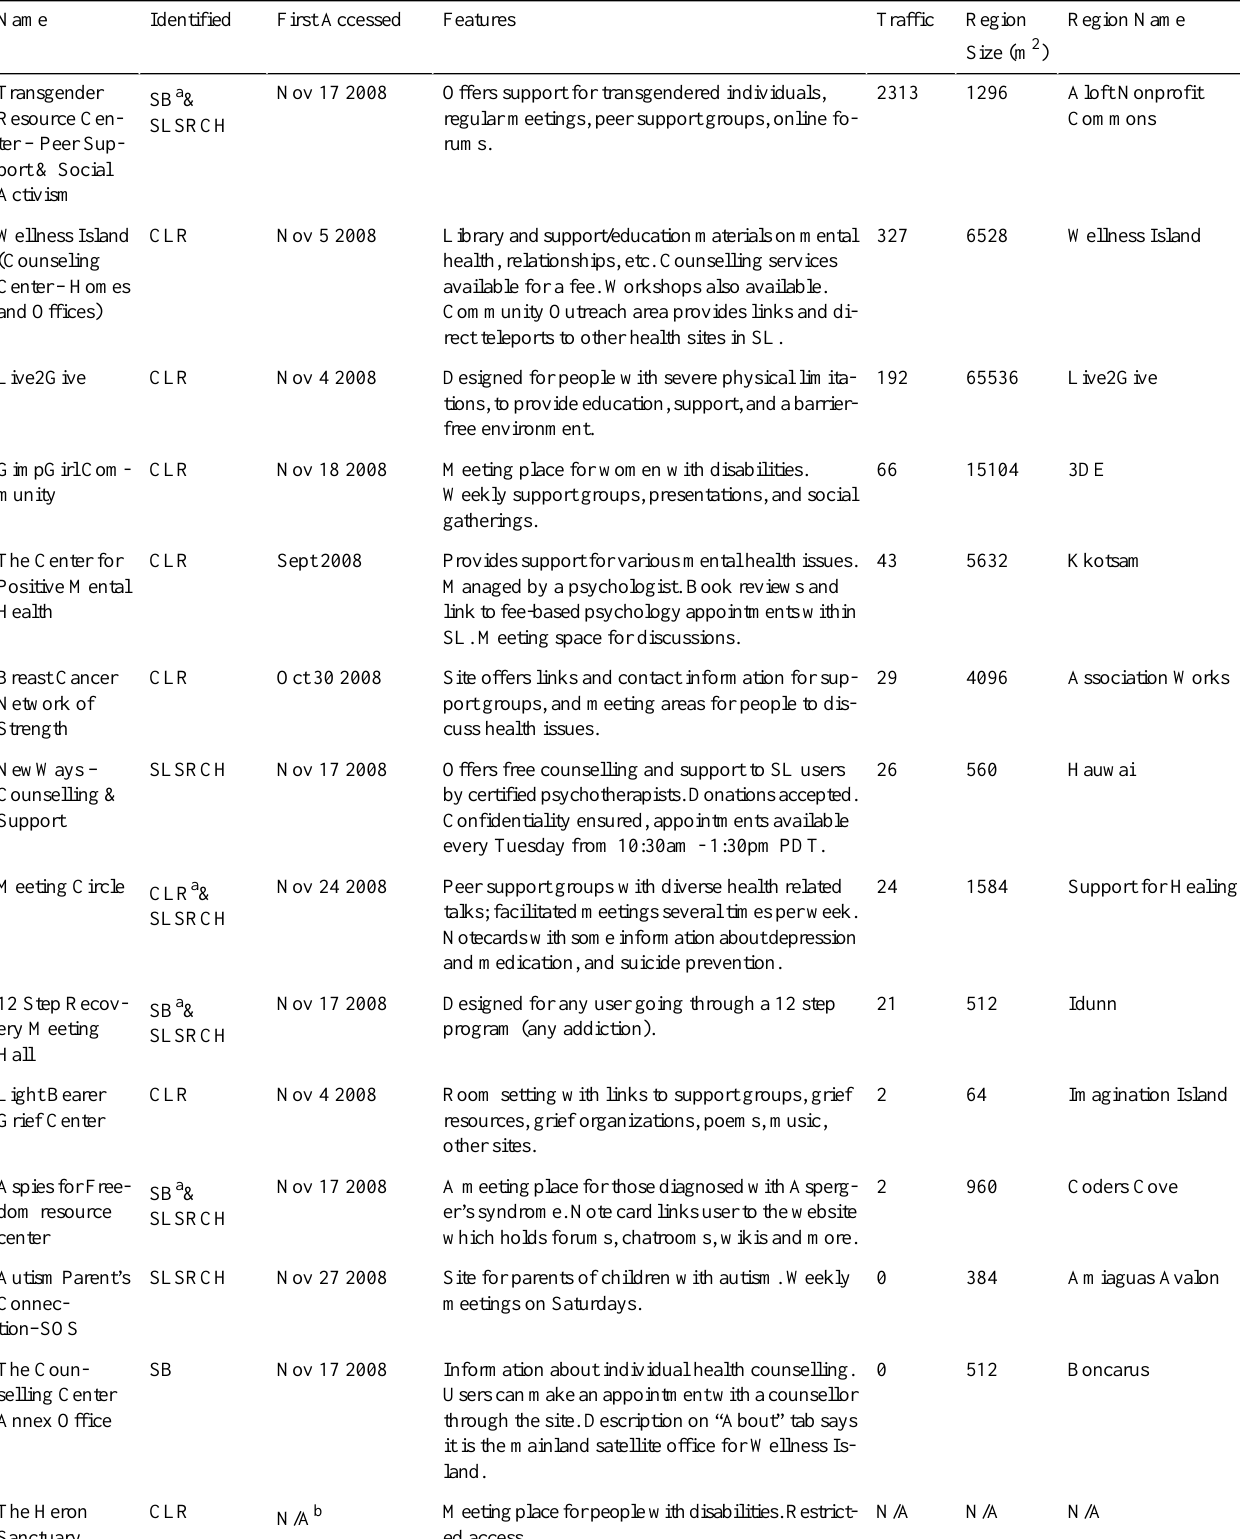
Table 3. Support sites (ranked by